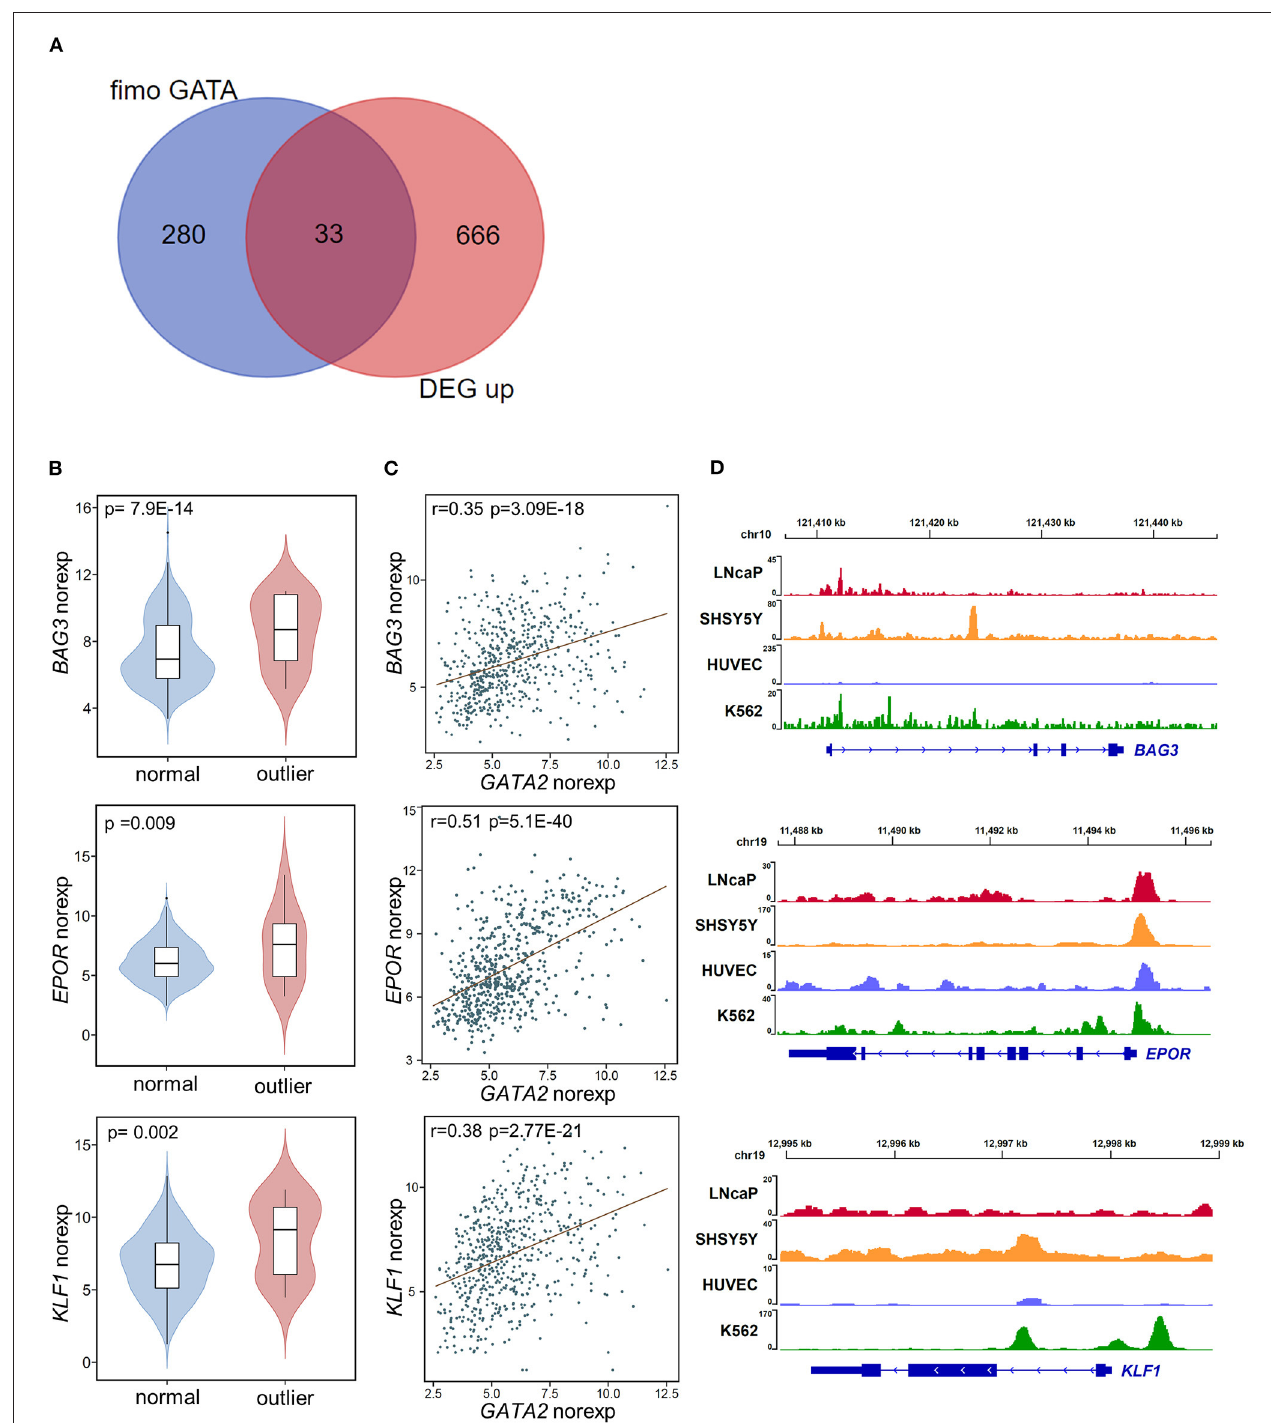
FIGURE 3 | Potential targets of GATA2 activation. (A) The overlap between potential GATA2 -targeted genes predicted by FIMO (left) and up-regulated DEGs (right). (B) Violin plots showing the normalized expression of the potential GATA2 -targeted genes BAG3 , EPOR , and KLF1 in the GATA2 -outlier and GATA2 -normal groups. The p -value from differential expression analysis is shown above each plot. (C) Scatter plots indicating the correlations between normalized expression levels of GATA2 (x axis) and the potential target genes (y axis). The correlation coefficient and p -value were determined by Pearson correlation analysis. (D) Wiggle plot of GATA2 ChIP-seq data from four tumor cell lines showing that the GATA2-binding site is located near the potential target genes in (B) .